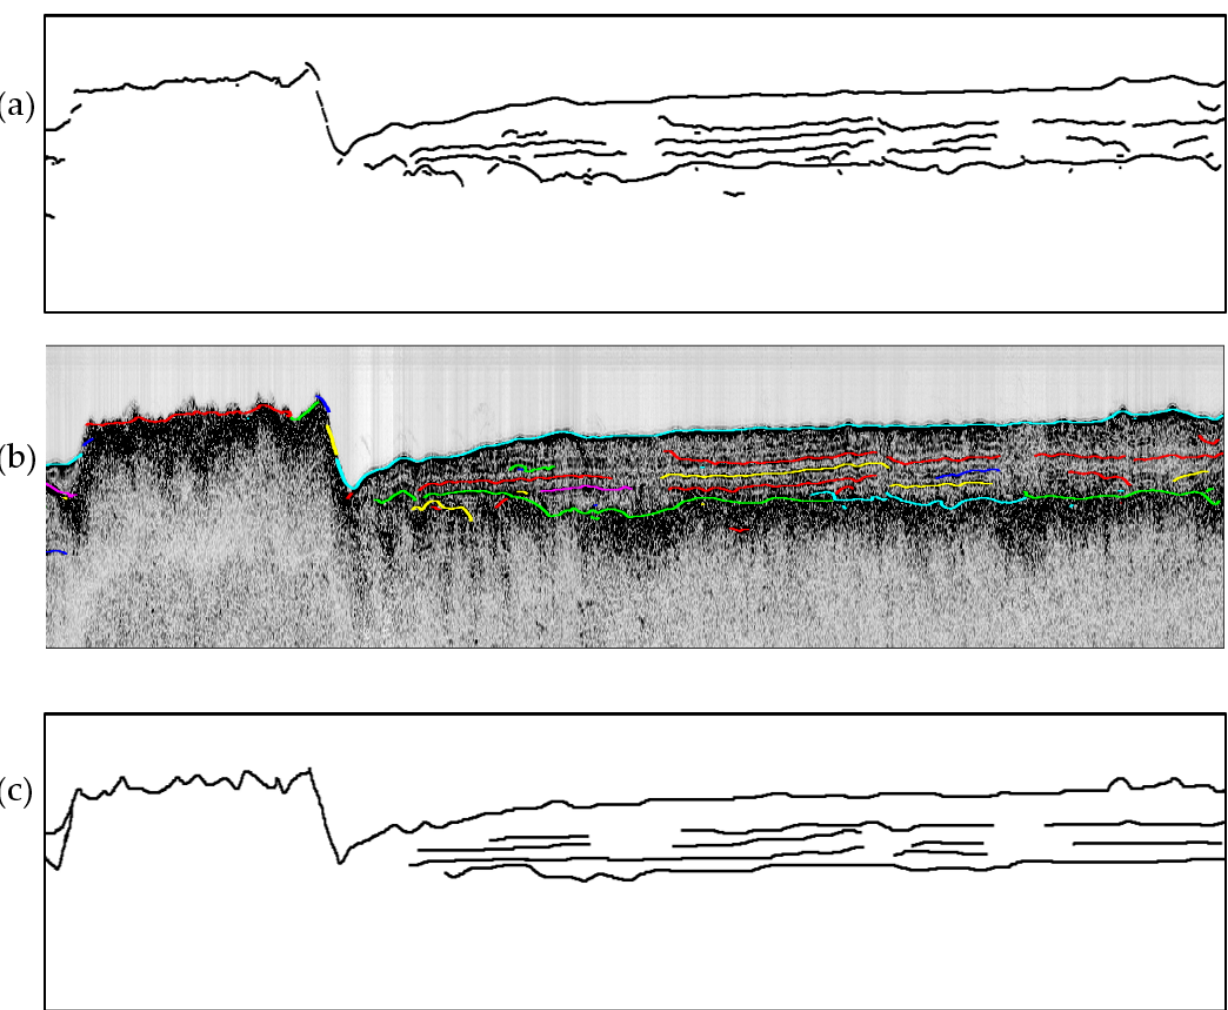
Figure 7. Result of horizon picking. ( a ) shows the final horizons after horizon fusion. ( b ) shows the superposition of picked horizons with the original SBP image. Horizon points belonging to the same horizon segment are assigned the same color. ( c ) shows the ground truth obtained through manual picking.